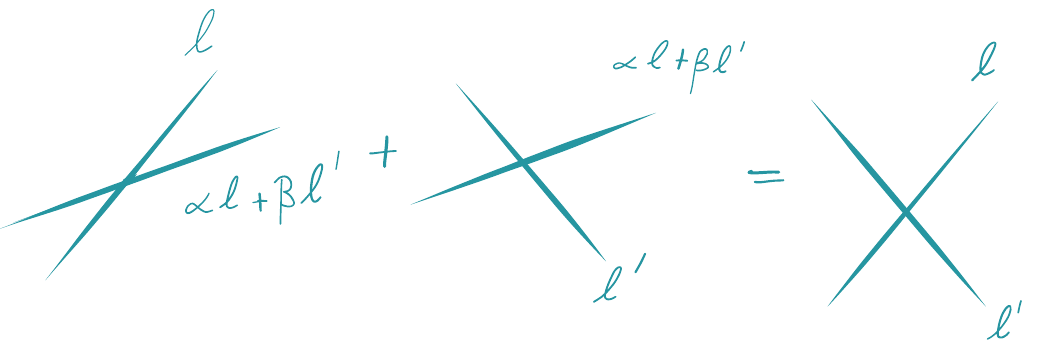
Figure 2 . Geometrical interpretation of the identities between d log